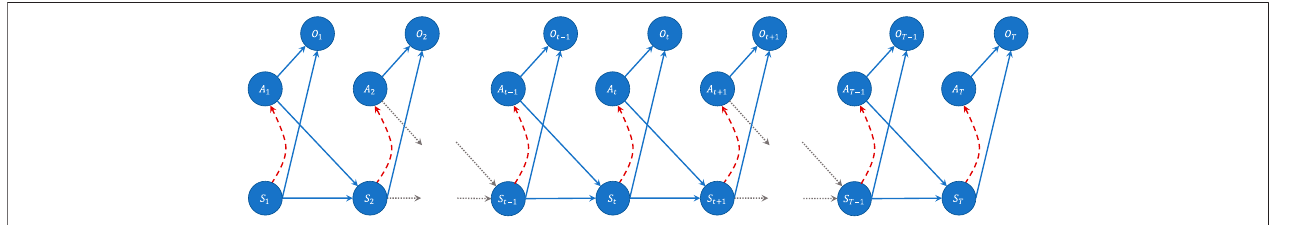
FIGURE 1 | Bayesian graph of the generative model of an MDP, in which the variable O t represents the optimum for that time